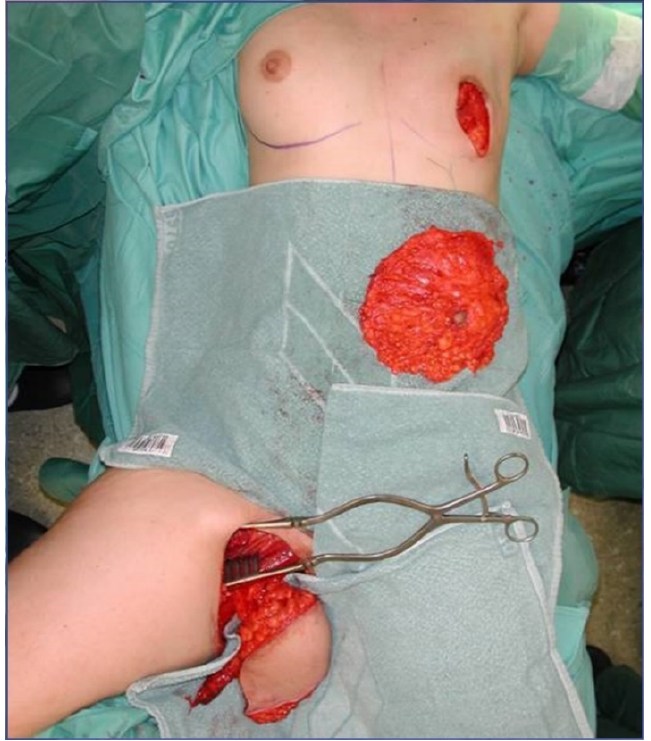
Figure 2. Intraoperative image after unilateral skin sparing mastectomy.